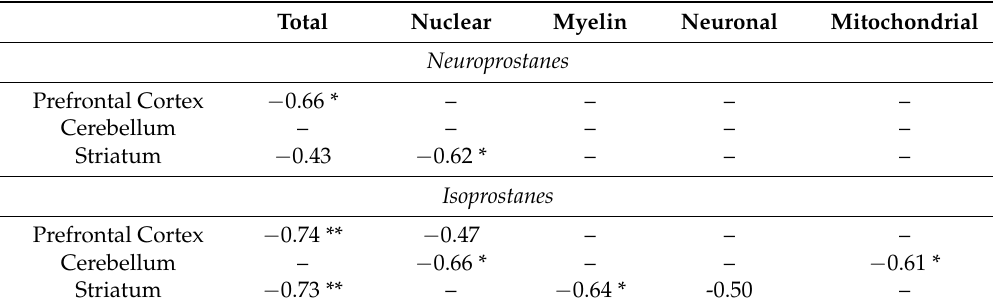
Table 4. Partial correlations between membrane α -tocopherol and neuroprostanes and isoprostanes from different brain regions of rhesus macaques ( n = 9). Total